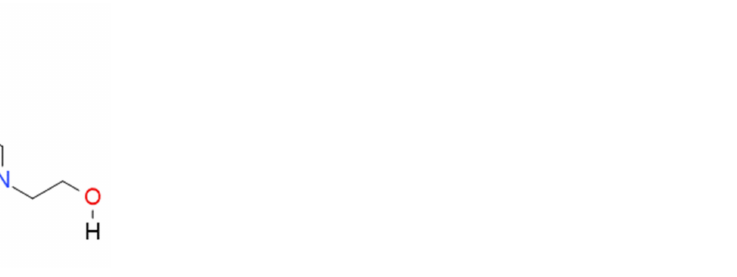
Figure 1. Hexahydro-1,3,5-tris(hydroxyethyl)-s-triazine chemical structural formula.